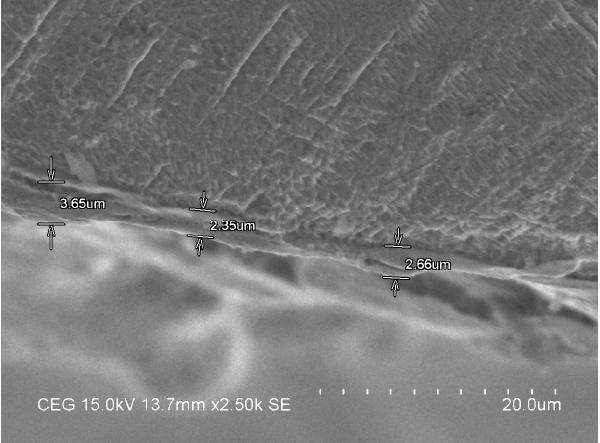
Figure 5. White layer distribution of machined specimen in WEDM process.